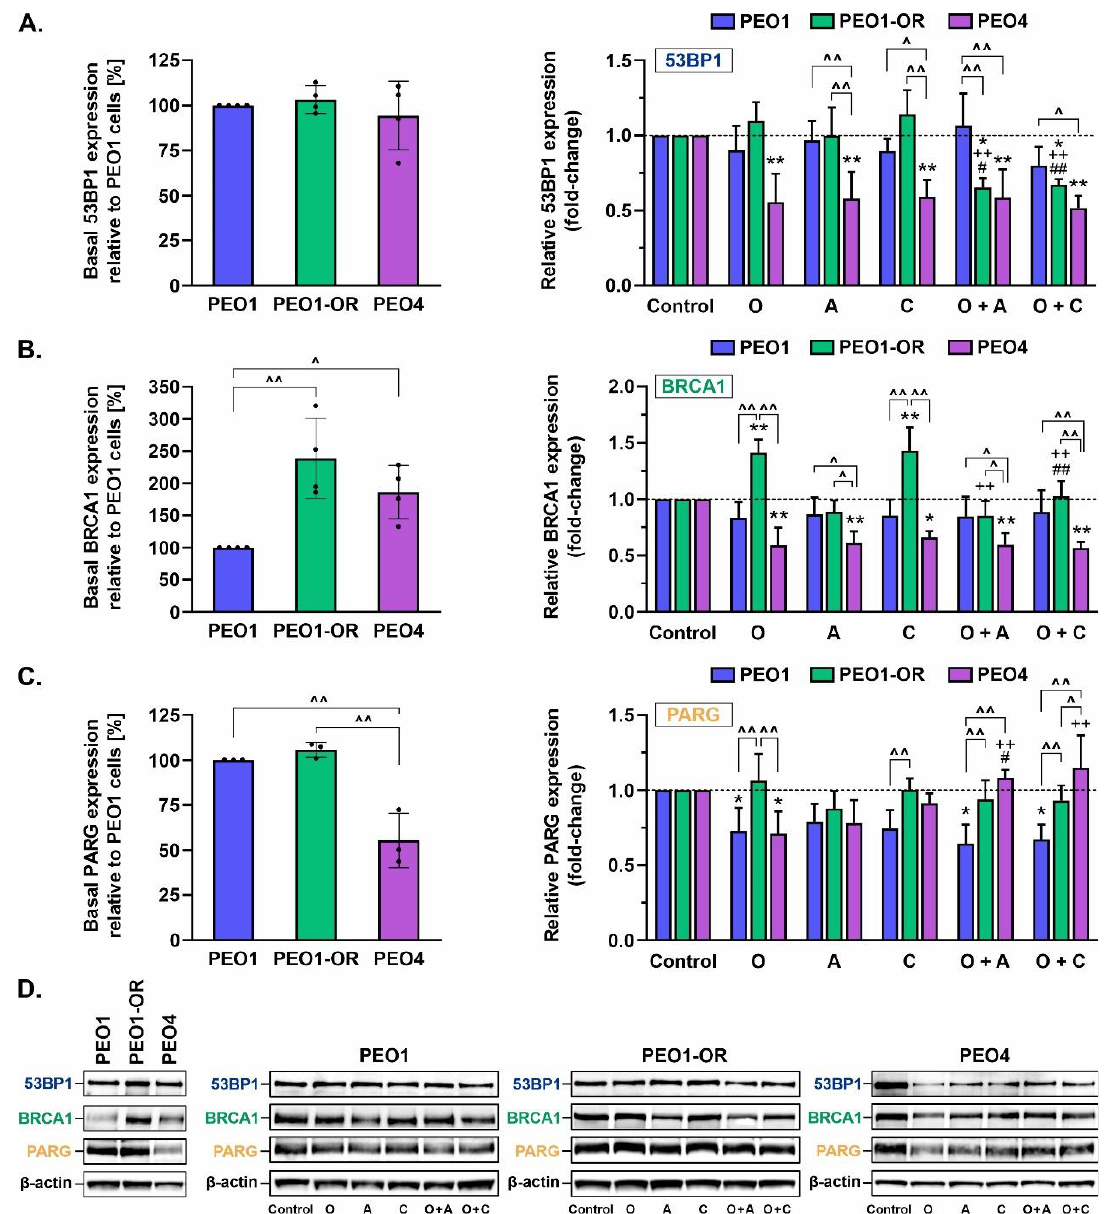
Figure 9. Changes in 53BP1, BRCA1, and PARG expression in OC cell lines treated with olaparib or inhibitors of the ATR/CHK1 pathway. Quantitative Western blot analysis was performed to assess basal expression of ( A ) 53BP1, ( B ) BRCA1, and ( C ) PARG. Protein levels upon treatment were quantified following normalization to β -actin as a loading control and calculated as fold-change relative to untreated controls. Cells were treated for 48 h with olaparib (O, 5 μM), ATRi (A, 0.5 μM), CHK1i (C, 2.5 μM), or their combinations, and whole-cell lysates were prepared immediately afterward. Data are expressed as mean ± SD ( n = 3 – 4). Statistical significance was assessed using ordinary one-way ANOVA (basal protein expression) and two-way ANOVA (responses to tested compounds), both followed by Tukey’s test . ^ p < 0.05, ^^ p < 0.01: differences between cell lines; * p < 0.05, ** p < 0.01: treatment vs. control; ++ p < 0.01: olaparib vs. combinations with ATRi or CHK1i; # p < 0.05, ## p < 0.01: ATRi or CHK1i vs. respective combinations with olaparib. ( D ) Representative Western blot images.